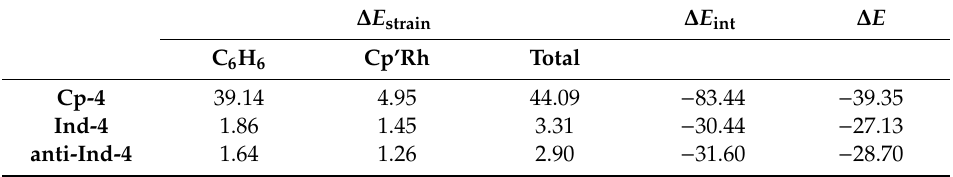
Table 2. Activation strain analysis for Cp-4 , Ind-4 , and anti-Ind-4 ; all values are in kcal mol − 1 . The fragments are Cp’Rh (Cp’ = Cp, Ind, and anti-[Cr(CO) 3 Ind]) and C 6 H 6 moiety (the reference is